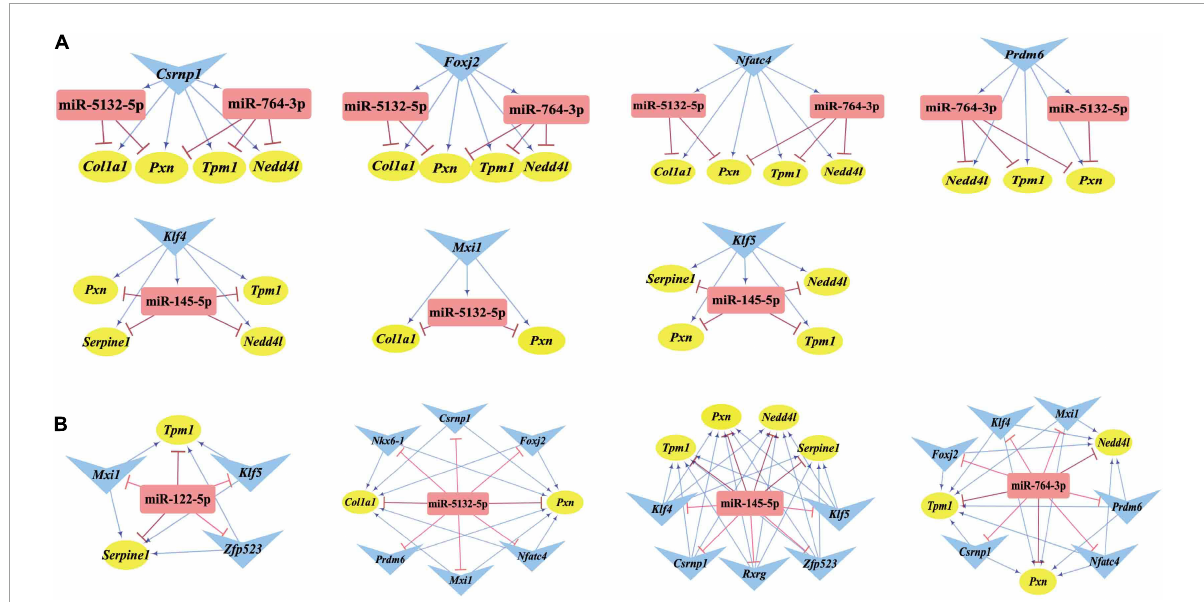
FIGURE8 Three-node FFLs formed by key nodes. (A) TFs-mediated three-node FFLs of individual key DETFs. (B) A total of four miRNA-mediated three-node FFLs of key DEMs of the present study. The gene, miRNA, and TF are represented with yellow circles, red rectangles, and blue triangles, respectively. The terminal of the edges radiating from the miRNA is marked in red and T-type blunt arrow, while the one that changed to sharp arrow for the edges that radiate from TF is in blue